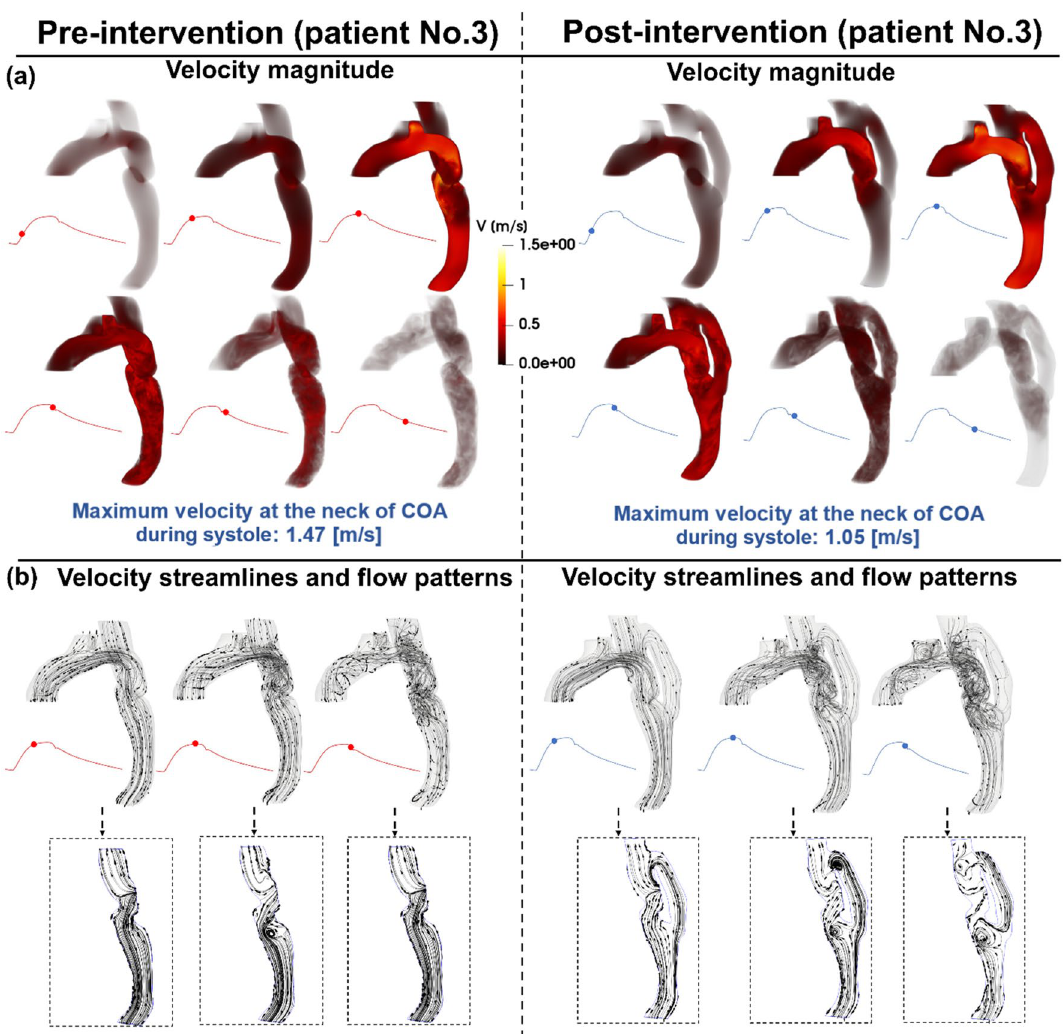
Figure 7. Flow modeling in Patient No. 3 in pre and post intervention status. ( a ) Time-evolving velocity magnitude at six instances; ( b ) 3-D (upper row) and 2-D (lower row) streamlines through the aorta at three instances. Baseline characteristics (Patient No. 1): moderate aortic stenosis, mild mitral regurgitation, severe COA, descending aorta aneurysm, and